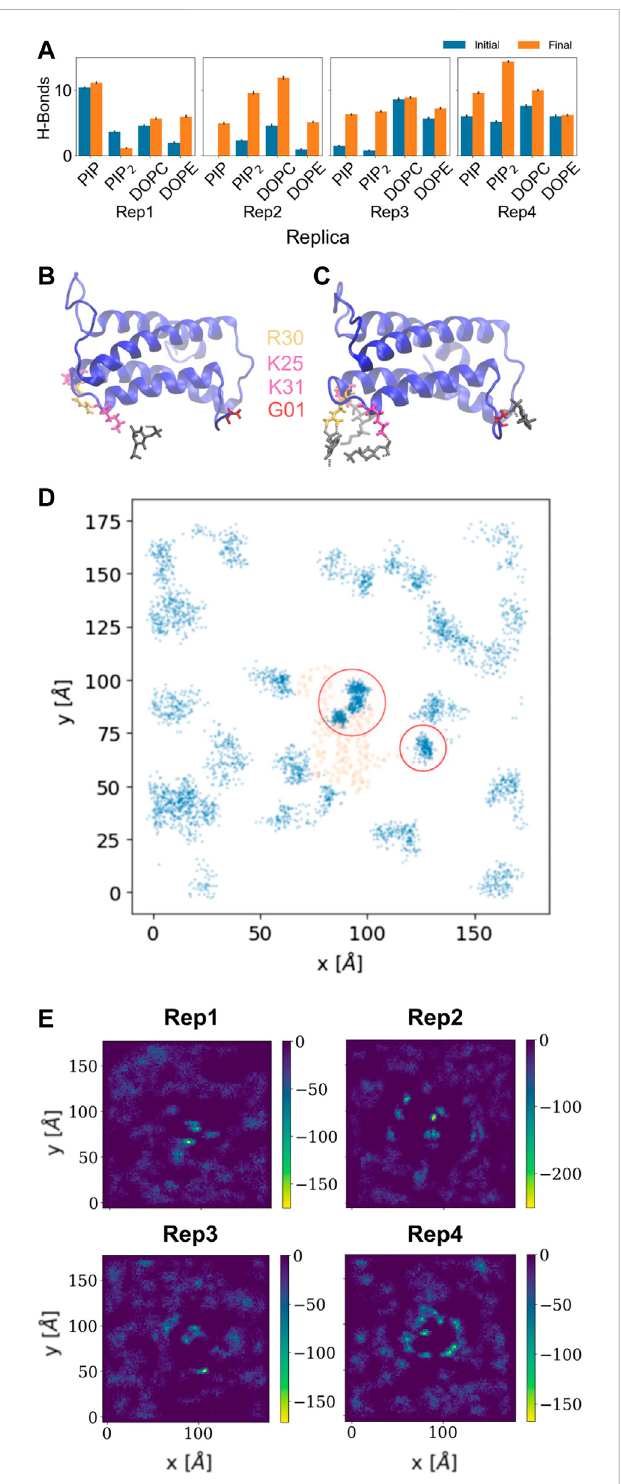
FIGURE 3 Hydrogen bonds and lipid recruitment upon MLKL binding. (A) Bar plots of the total number of hydrogen bonds between protein and lipids for each replica during the fi rst 500 ns (in blue) versus the last 500 ns (in orange). Close-up of hydrogen bonds between PIP lipids and the 4HB domain at: (B) 200 ns, and (C) . 2000 ns. The 4HB domain is shown in blue, PIP lipid headgroup in black, R30 residue in yellow, K25 and K31 in pink, and G01 in red. (D) Cumulative plot of the lateral distribution of PIP lipids as estimated from the location of the lipid phosphate atoms for the last 200 ns. Blue points indicate the phosphate atom positions